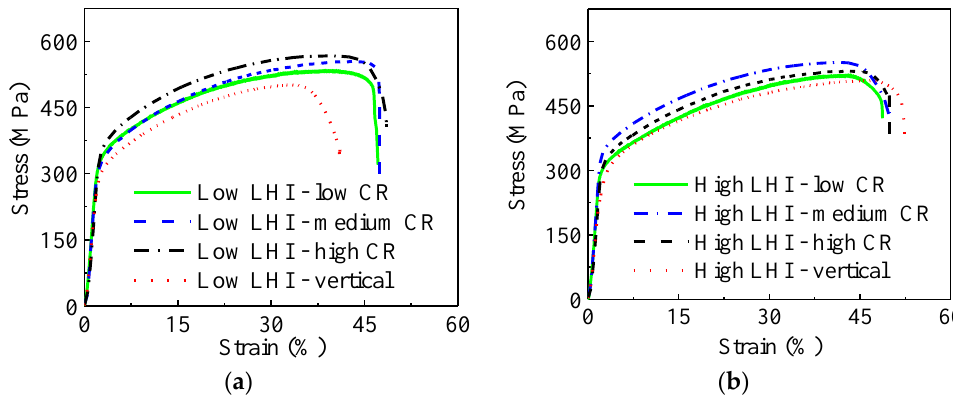
Figure 7. Engineering stress–strain relationships of the studied steel under: ( a ) low LEI, ( b ) high LEI.